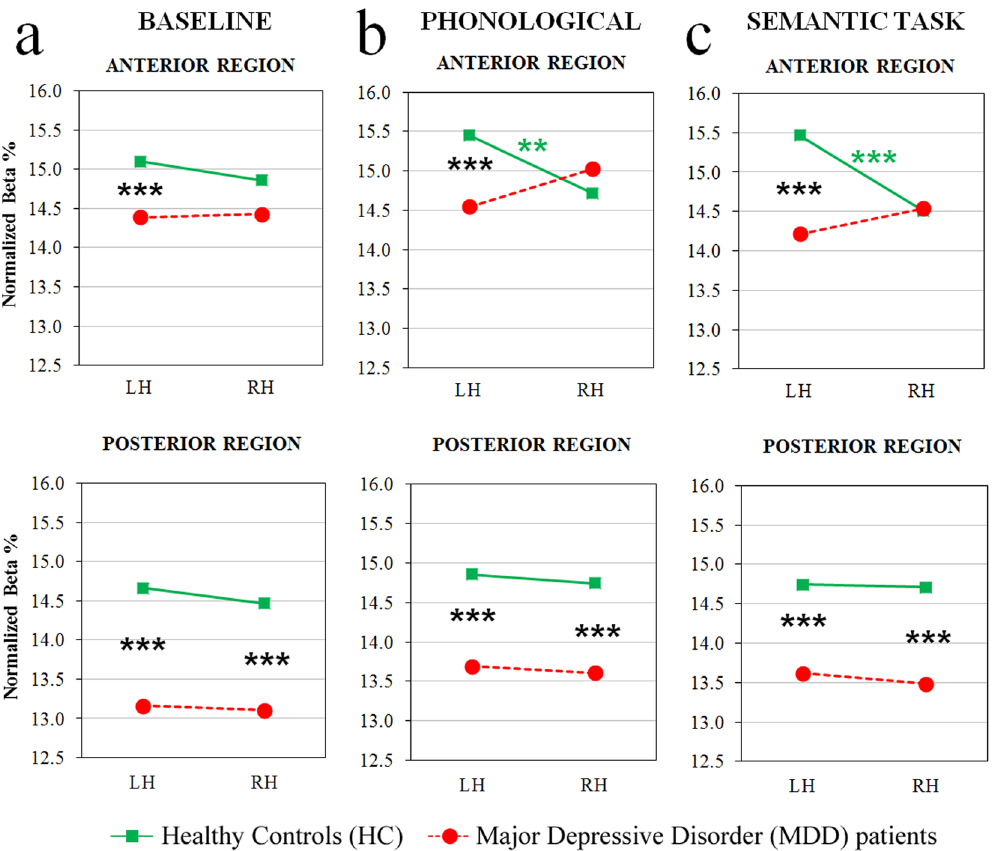
Figure 5. Beta band analysis: significant four-way Group by Task by Region by Laterality interaction. Beta distributions to resting state, baseline condition (left panels), phonological (middle panels) and semantic tasks (right panels) are shown for anterior (top row) and posterior brain regions (bottom row), for HC and MDD patient groups (green and red dotted lines, respectively). Asterisks: significant (p < 0.05) post-hoc